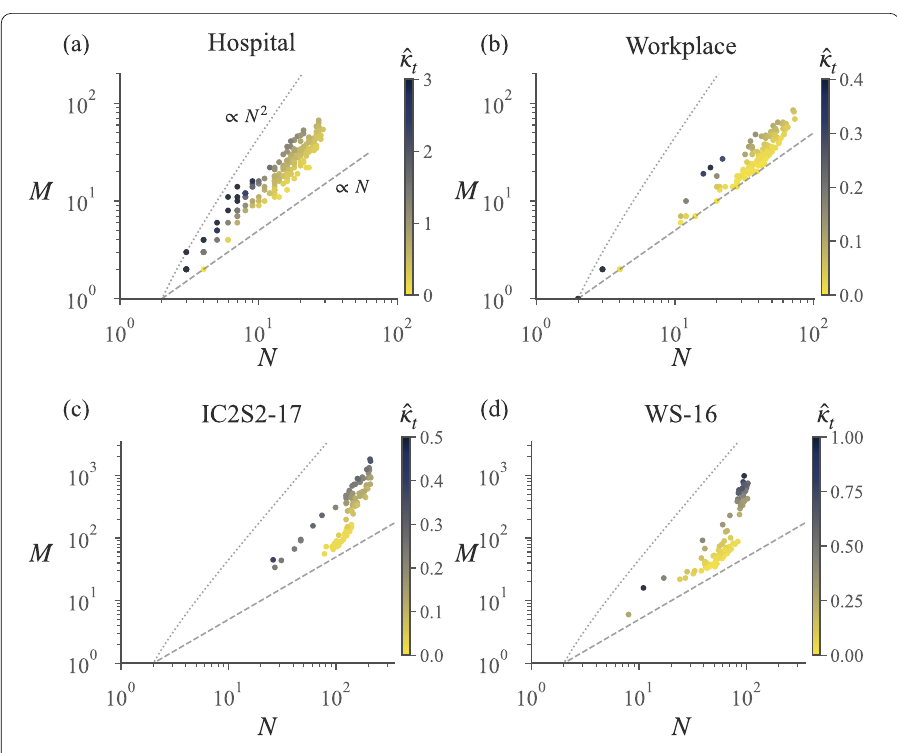
Figure 7 Densification scaling and changes in overall activity (cid:6) κ t in face-to-face networks. N - M scaling plots are shown for ( a ) Hospital on December 7, 2010 ( b ) Workplace on June 27, 2015 ( c ) IC2S2-17 on July 11, 2017 and ( d ) WS-16 on December 1, 2016. Each dot represents a snapshot of the network and colors denote estimated population size (cid:6) N p , t based on the respective color bar. Gray dashed and dotted lines show theoretical lower ( M = N /2) and upper ( M = N ( N – 1)/2) bounds. Estimates are based on Eq.